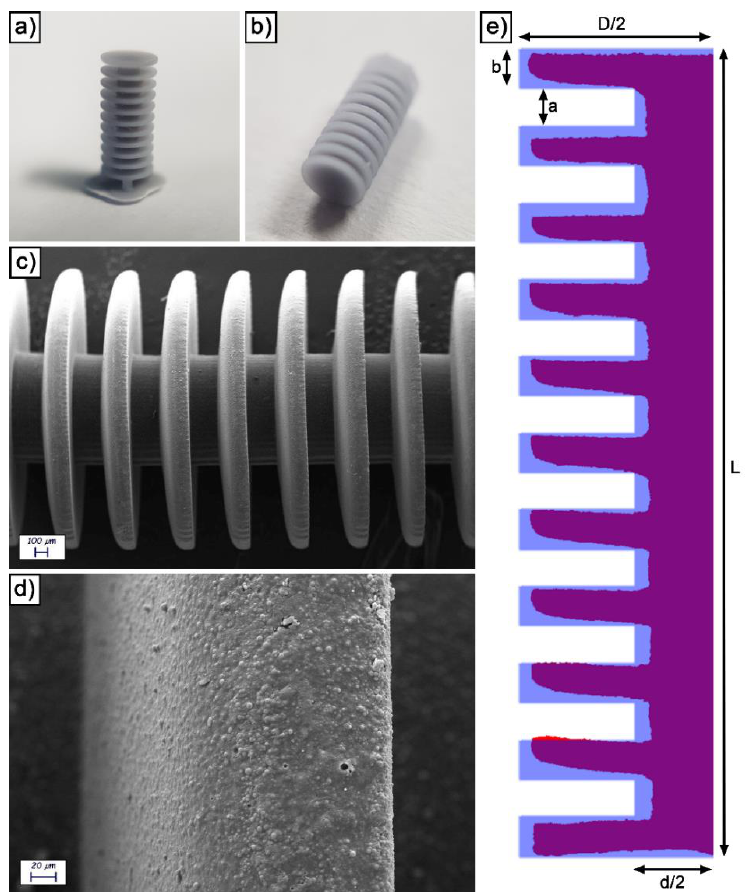
Figure 1. Visual appearance of an as printed device before ( a ) and after ( b ) printing supports removal; SEM images of an as printed device observed at 100 X ( c ) and 1000 X ( d ); visual comparison between the experimental and theoretical section of a device ( e ).